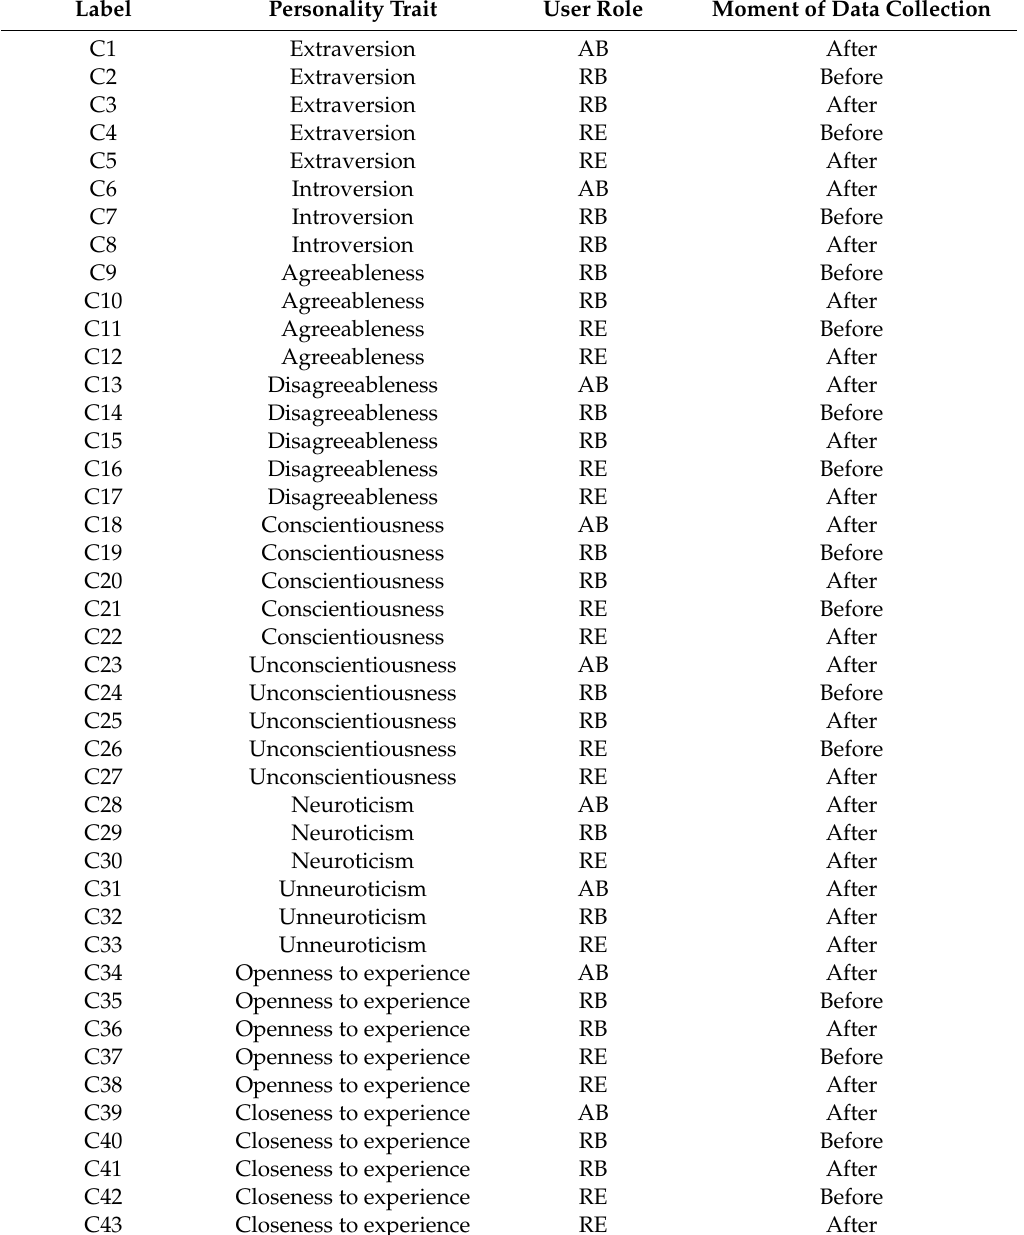
Table 4. Combinations of personality traits, user roles and moments of data collection.